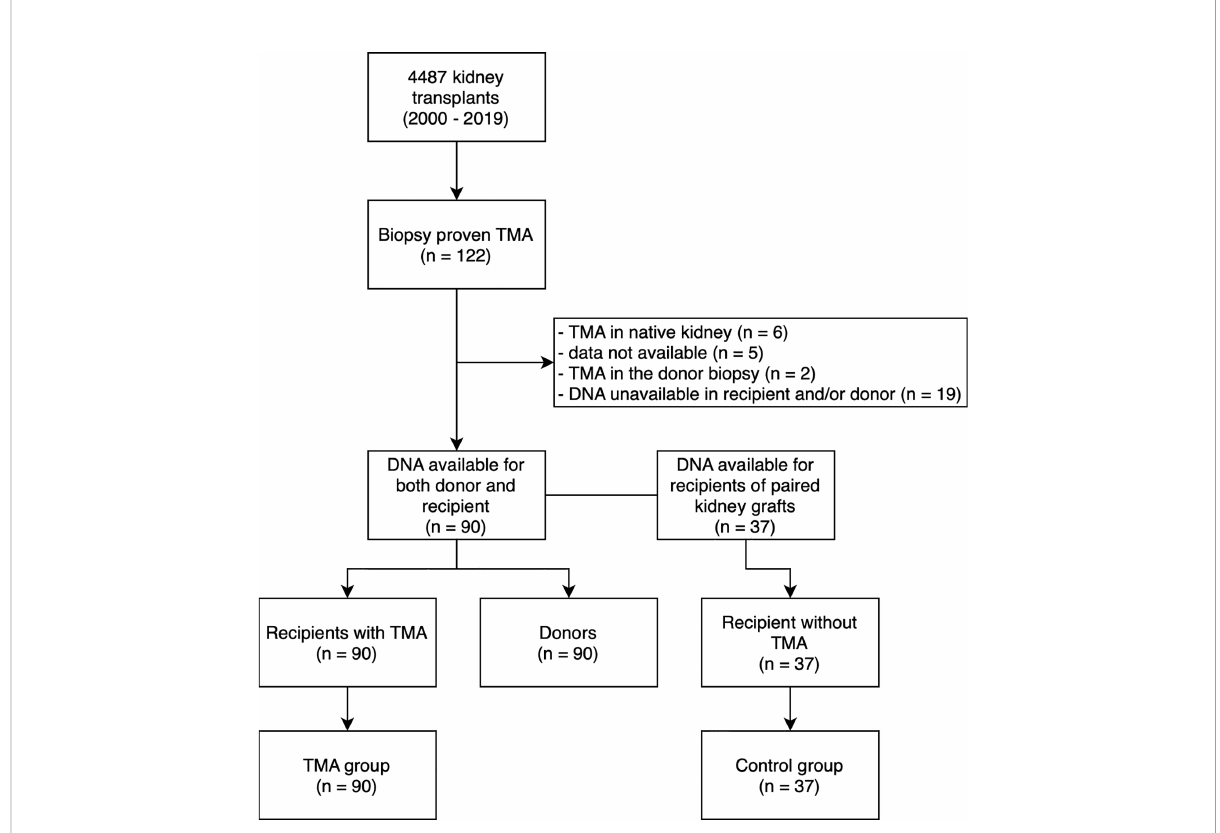
FIGURE 1 Study fl ow diagram. TMA, thrombotic microangiopathy; DNA, deoxyribonucleic